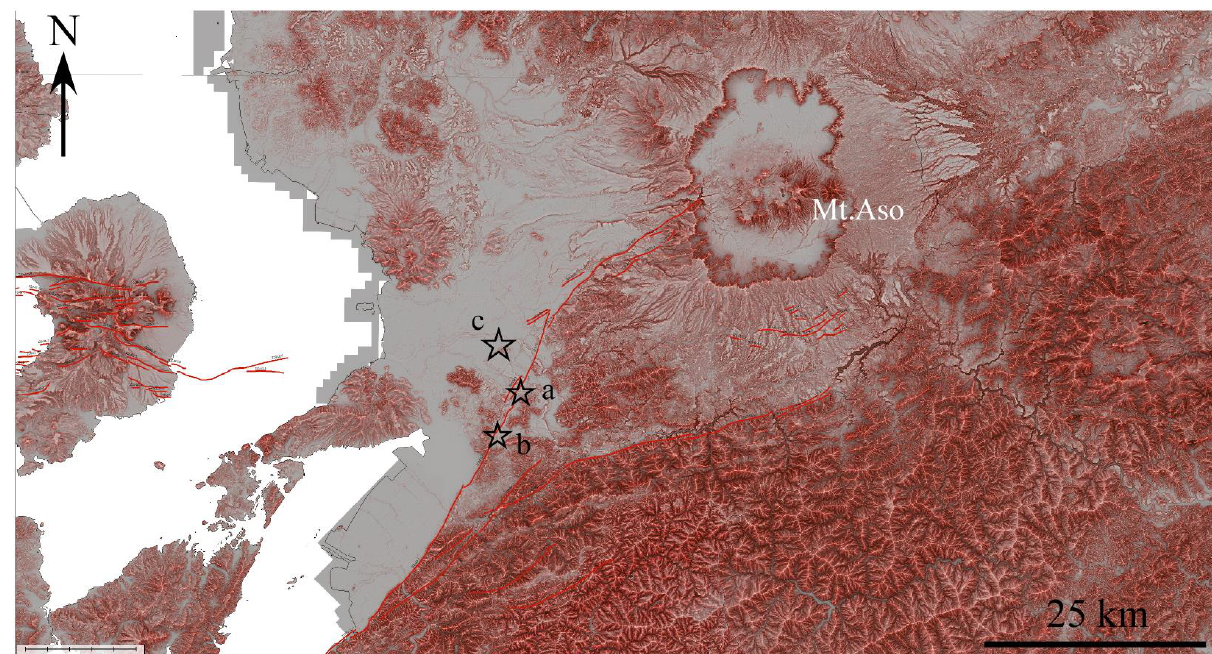
Figure 9. Topographic features of the region involves the 2016 Kumamoto earthquake. Stars indicate epicentres of main earthquakes, a)The M6.4 earthquake occurred on April 14, 2016; b) The M6.5 erthquake occurred on April 15, 201 ６ , c)The M7.3 earthquake occurred on April 16, 2016. Red lines indicate urban active faults (AIST,